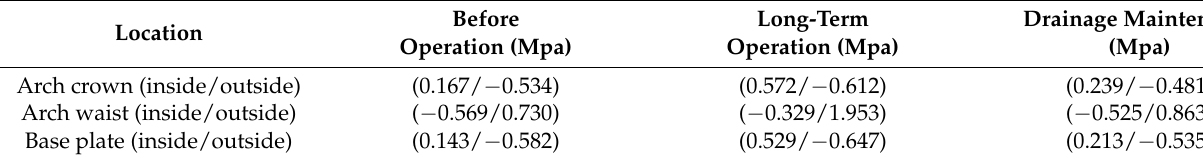
Table 5. Maximum principal stress of the pipe piece.